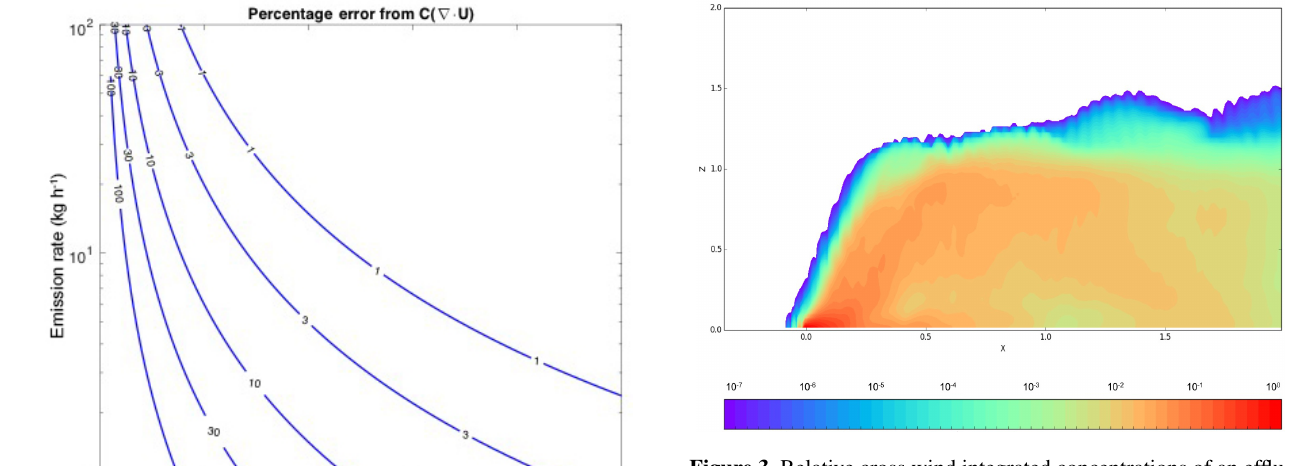
Figure 3. Relative cross wind integrated concentrations of an efflu- ent plume released at the surface in the UCD50B simulation. The data are averaged over 15min of simulation time and normalized by the maximum